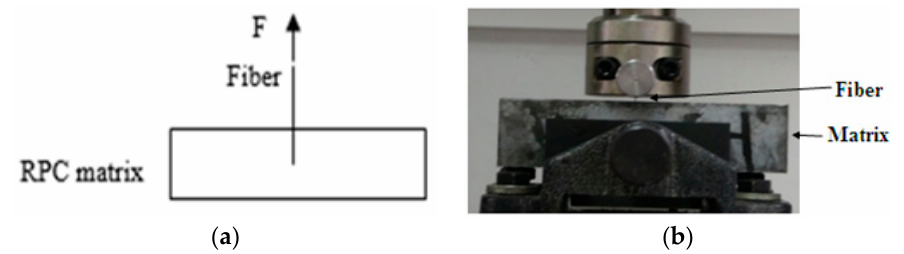
Figure 1. Single-fiber pull-out test: ( a ) schematic and ( b ) photo.